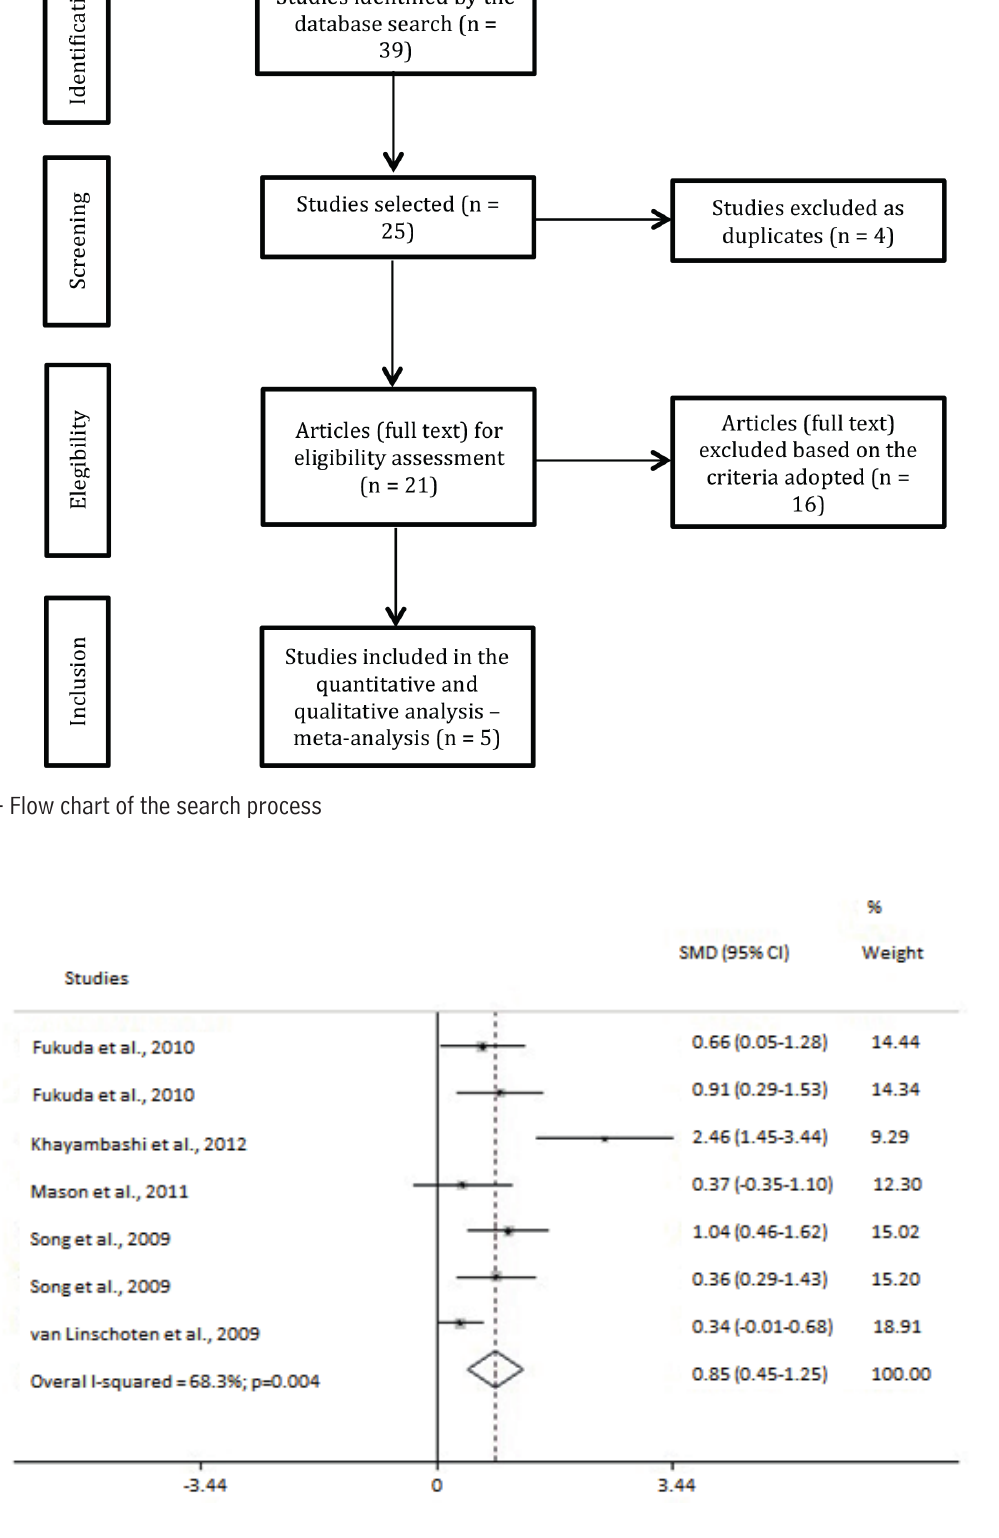
Figure 2 - Forest plot of the effect of exercise on